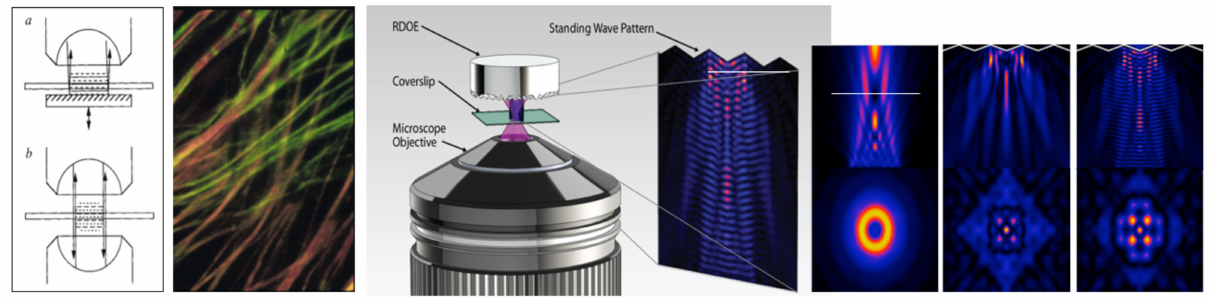
Figure 4. Standing wave (left) and Omnidirectional standing wave microscopy (OSWM) (right). Left: standing wave (SW) ( a ) and 4 π ( b ) optical excitation schematics, and pseudocolor SW images of fluorescent actin fibers in a cell Red/green), spaced axially 35 nm apart, and easily resolved. On the right, the structured standing wave pattern resulting from interference of the incident illumination and light reflected from the RDOE excites fluorescence at the specimen plane. An expanded view of the structured standing wave pattern is shown at the right of the objective. In the rightmost insert images, the same patterns are shown (L to R) without the RDOE; with the RDOE, and with the RDOE, after interference. The delicate interference patterns can be gently moved (e.g., piezoelectrically) to selectively illuminate very small specimen